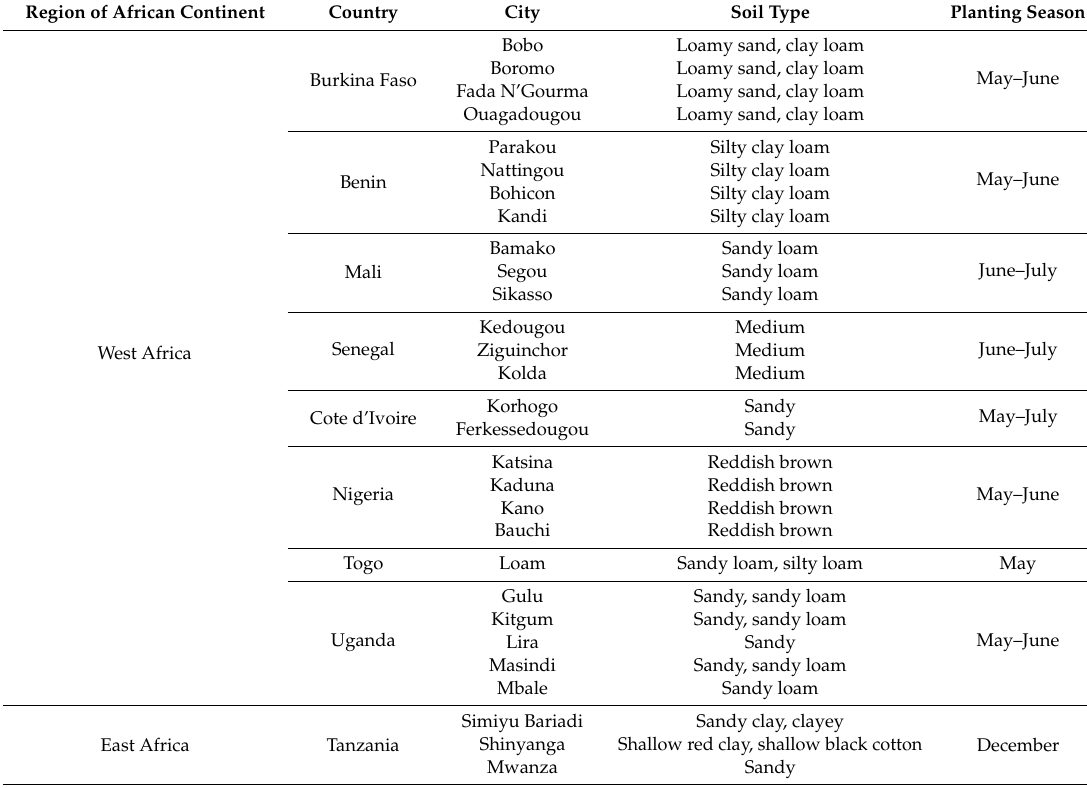
Table A11. Soil type and cotton planting season of di ff erent cotton producing states of East and West Africa [122–147].